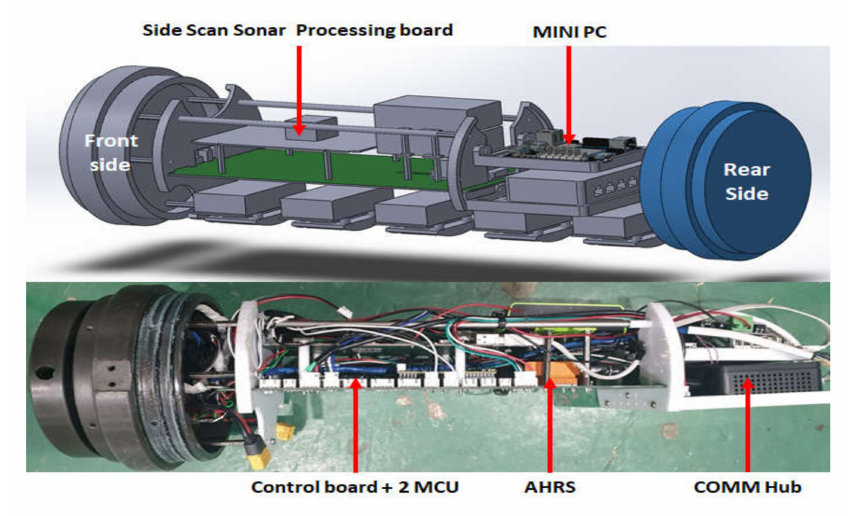
Figure 13. Configuration of UUV control